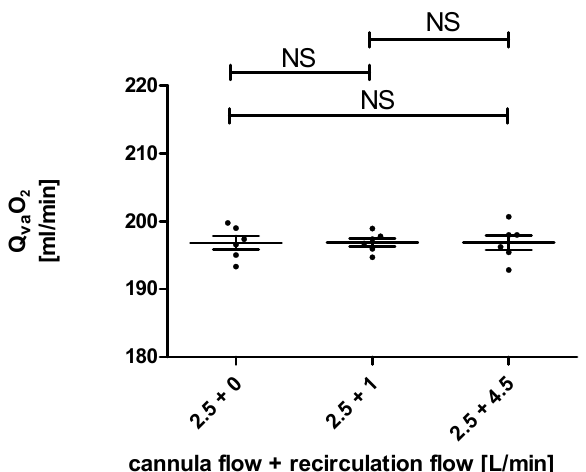
Figure 5. The calculated oxygen transfer rates over the membrane lung (Q va O 2 ) for a cannula blood flow of 2.5 L/min and blood flows over the recirculation loop of 0 L/min, 1 L/min, and 2.5 L/min are not significantly different (NS).